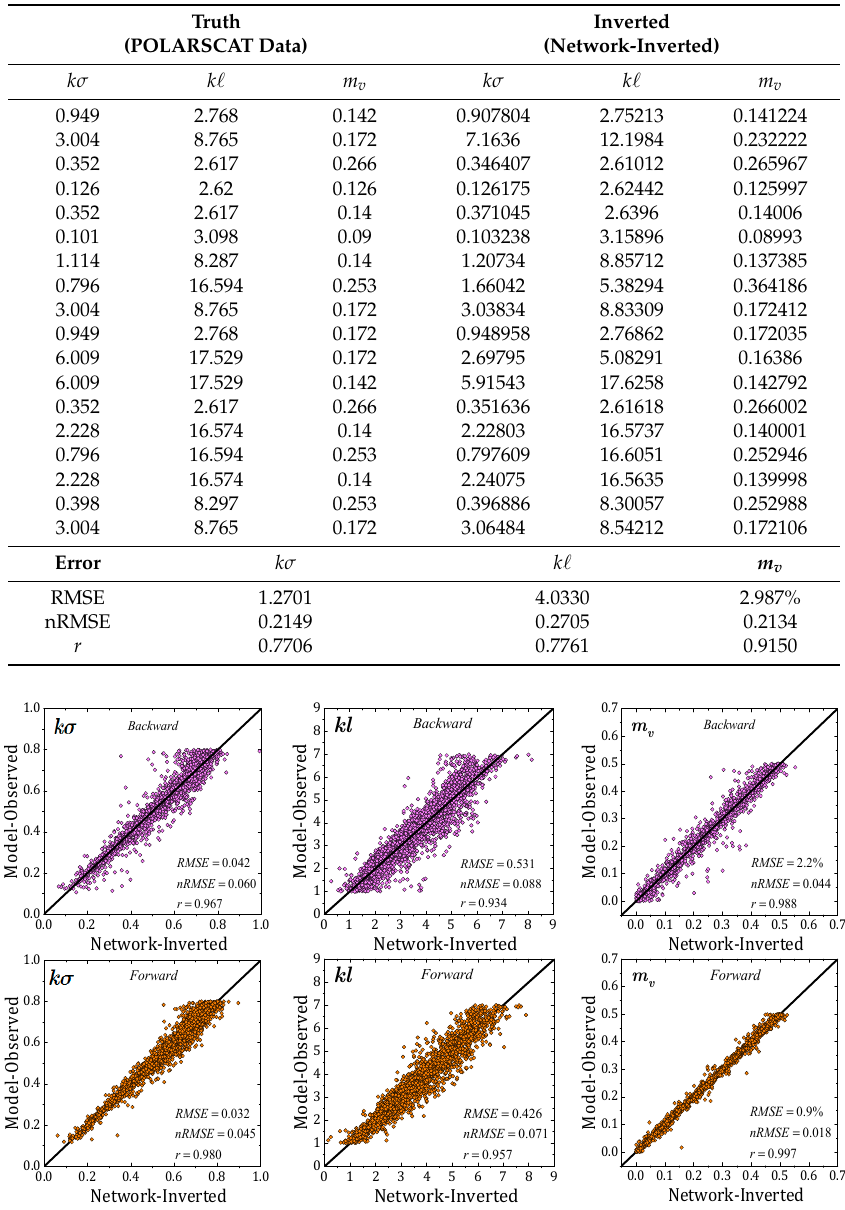
Figure 11. Retrieval performance of surface roughness and soil moisture from bistatic scattering data (four-input). Top row: backward region. Bottom row: forward region. Table 5. DLNN inversion performance using backscattering and bistatic scattering.